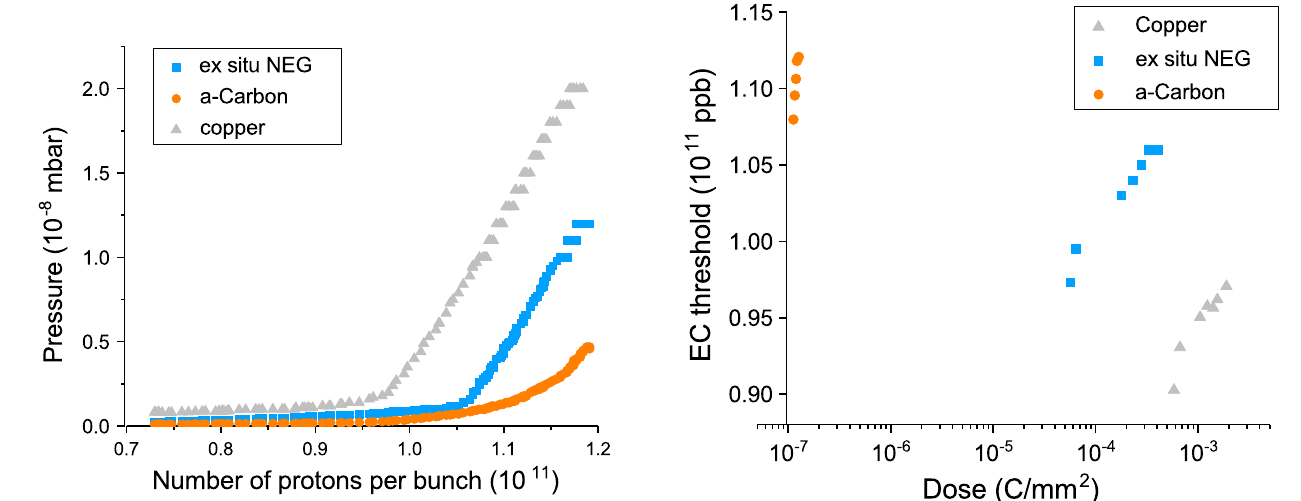
scale.FIG. 10. Bunch population threshold to trigger electron multi- pacting as a function of the accumulated electron dose during the 2017 ’ s scrubbing